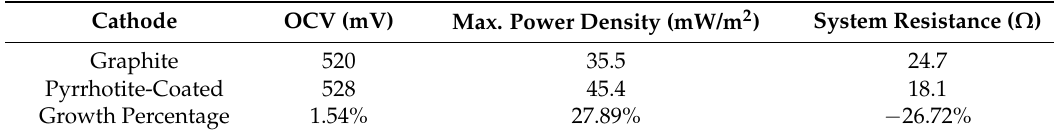
Table 1. The average electrical parameters in MFCs systems with different cathodes.